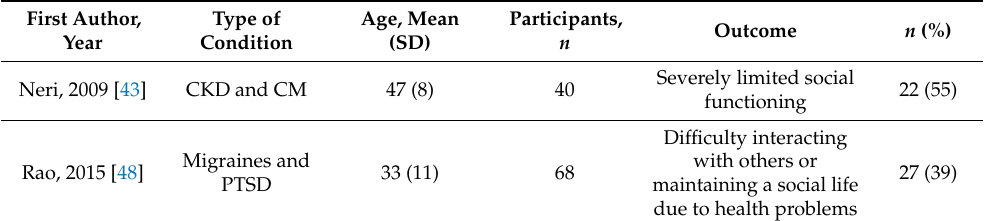
Table 10. Social affective functioning